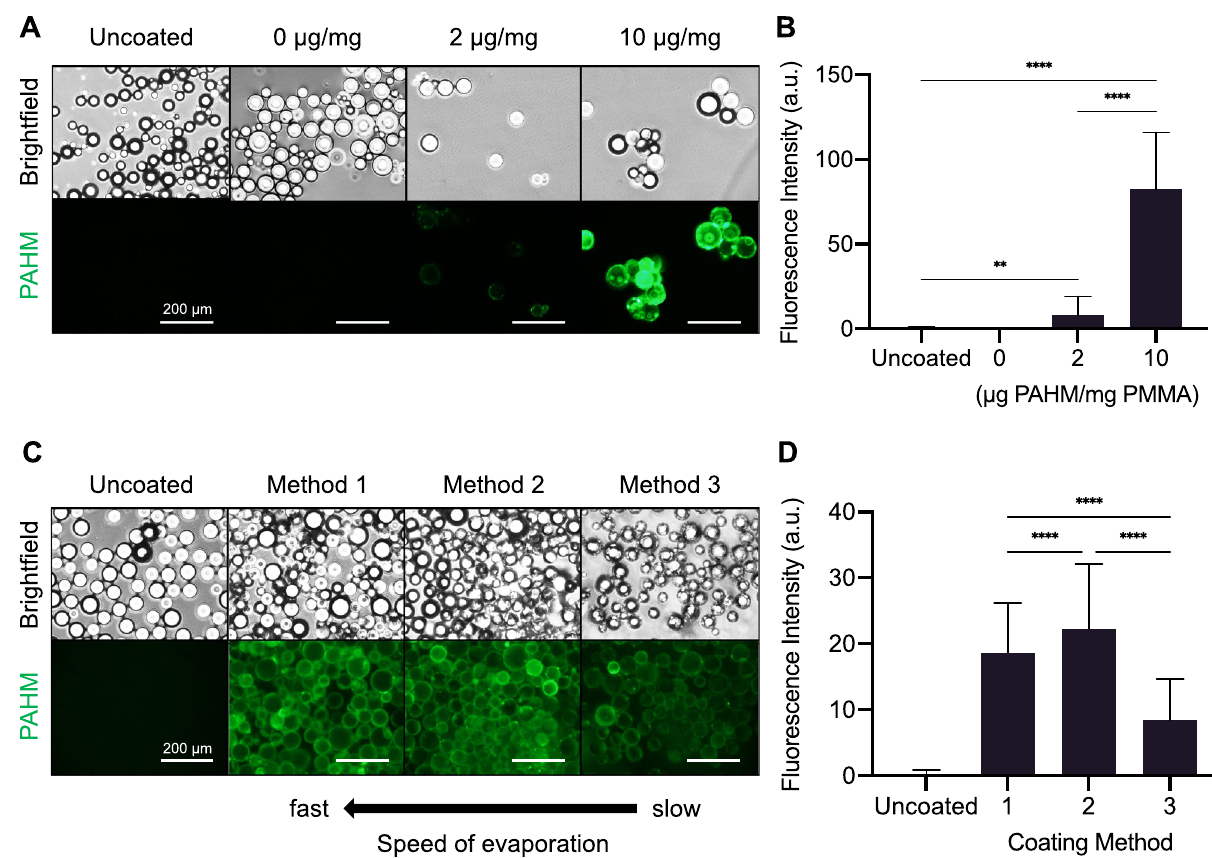
Figure 4. Characterization of embolic microspheres coated with fluorescently labeled PAHM. ( A ) Representative fluorescence microscopy images of microspheres coated with different amounts of PAHM (µg PAHM/mg PMMA). ( B ) Fluorescence intensity of PAHM coating on individual microspheres. ( C ) Representative fluorescence microscopy images of microspheres coated with PAHM by different solvent evaporation methods. ( D ) Fluorescence intensity of PAHM on individual microspheres after coating by different methods. Data are shown as mean ± SD (A) (n = 16–63) ( B ) (n = 165–186). ANOVA with Tukey HSD test (*p < 0.05, **p < 0.01, ***p < 0.001, ****p <